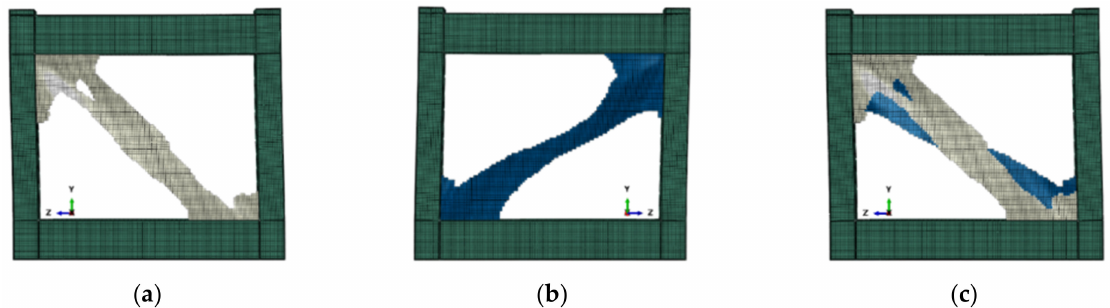
Figure 8. Nonlinear optimization results of SPSW with an aspect ratio of 0.75. ( a ) Front side. ( b ) Reverse side. ( c ) Distribution of stiffening